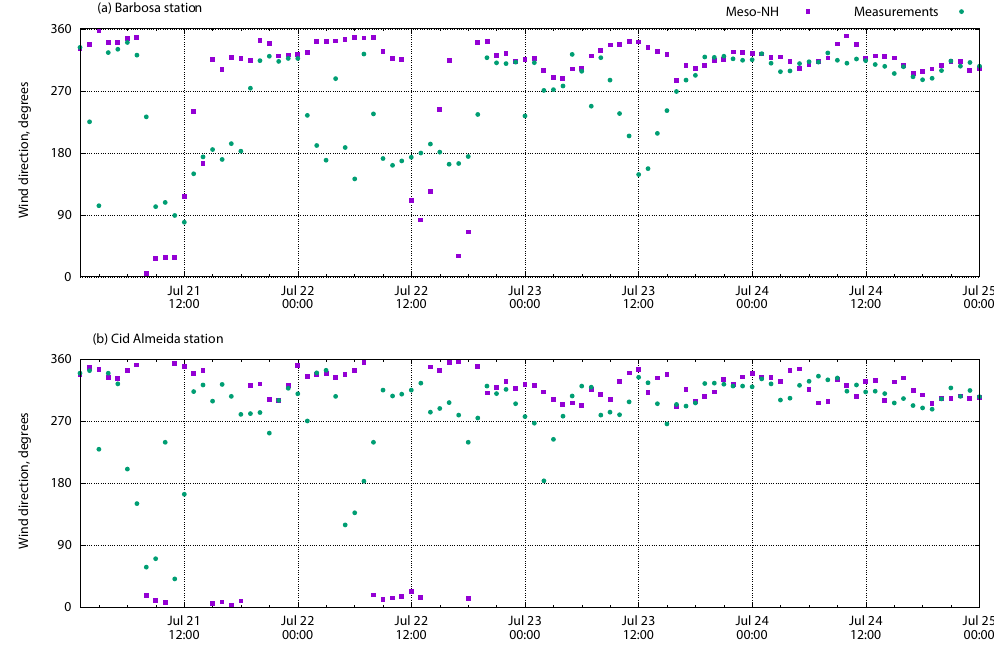
Figure 8. Observed and simulated wind direction at Barbosa and Cid Almeida